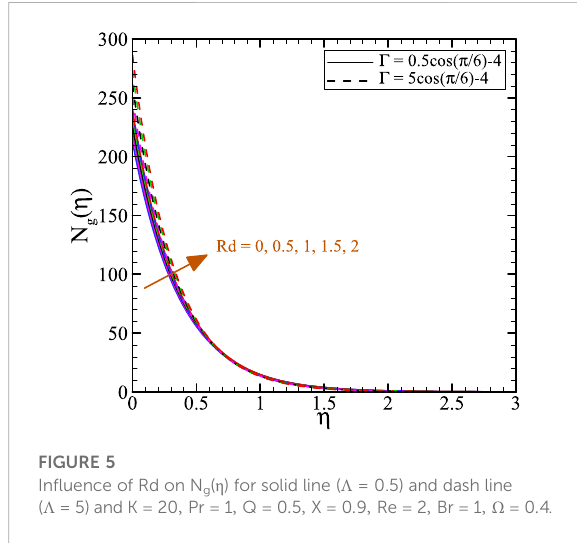
FIGURE 5 In fl uence of Rd on N g ( η ) for solid line ( Λ = 0.5) and dash line ( Λ = 5) and K (cid:3) 20 , Pr (cid:3) 1 , Q (cid:3) 0 . 5 , X (cid:3) 0 . 9 , Re (cid:3) 2 , Br (cid:3) 1 , Ω (cid:3) 0 . 4.